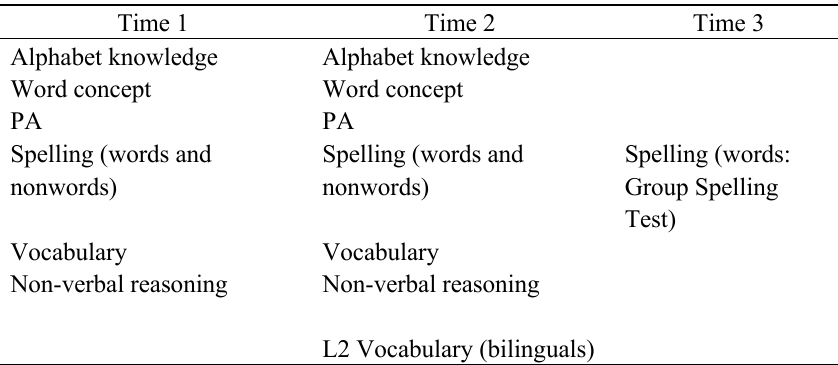
Table 1. Measures given to both monolinguals and bilinguals at three